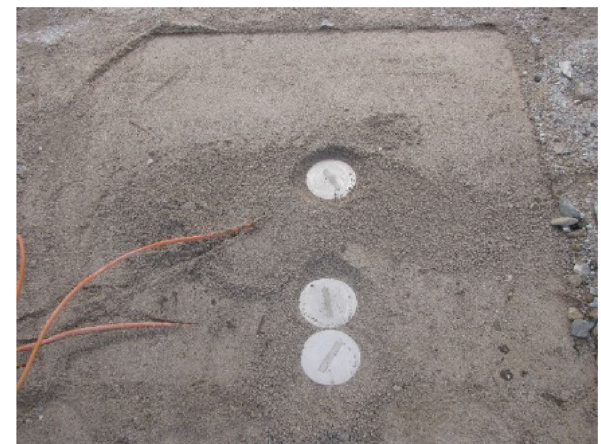
Fig. 9 Experimental setup details: soil pressure